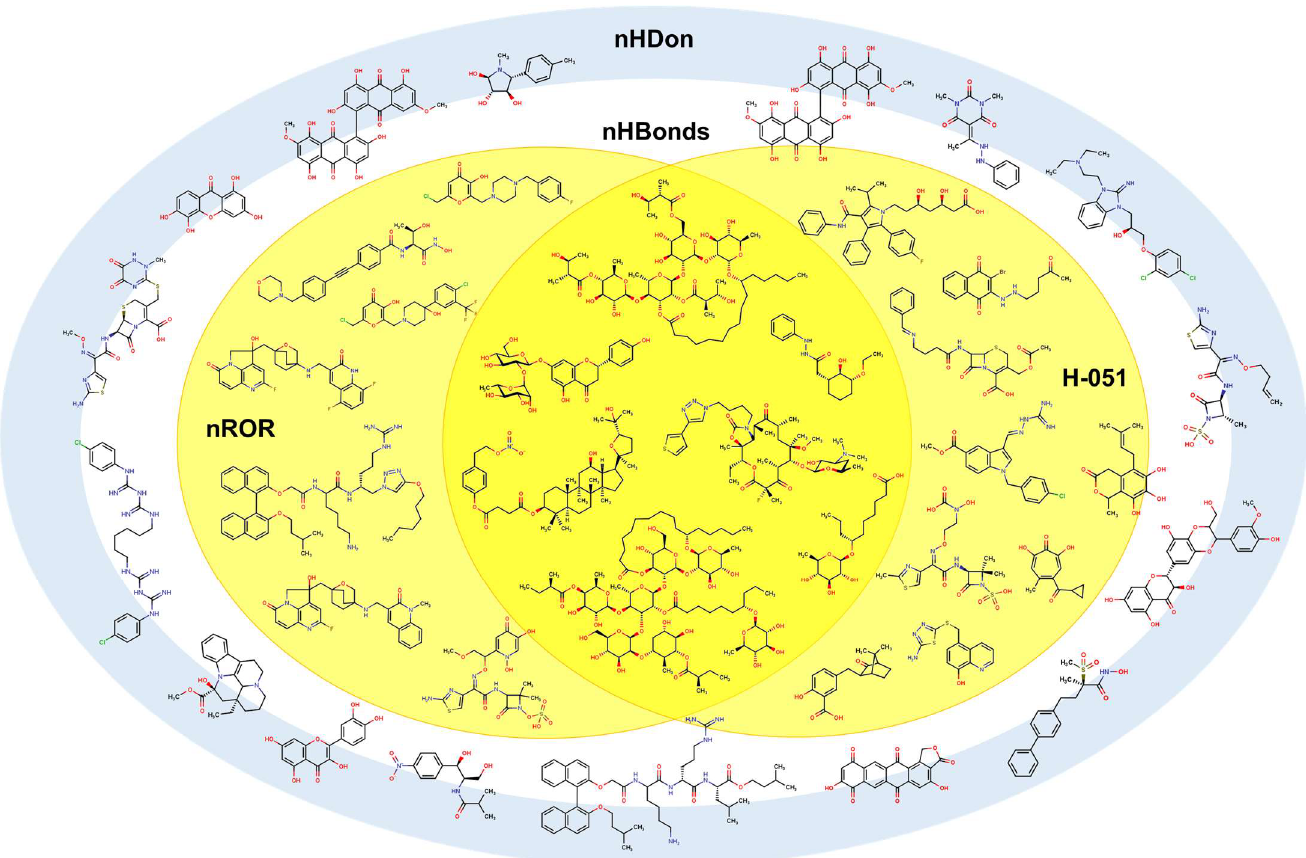
Figure 18. Simplified Venn diagram with representative molecules showing the nHDon, nHBonds, nROR, and H-051 descriptors which appear in molecules 54 to 68 .